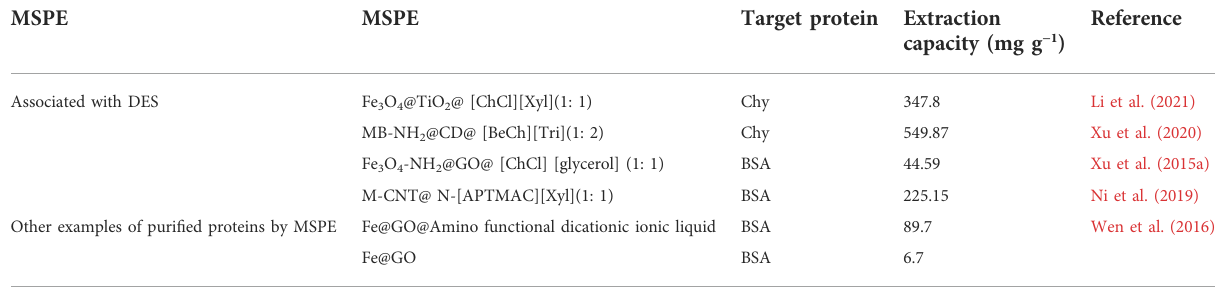
TABLE 6 Application of DES for protein puri fi cation using MSPE.